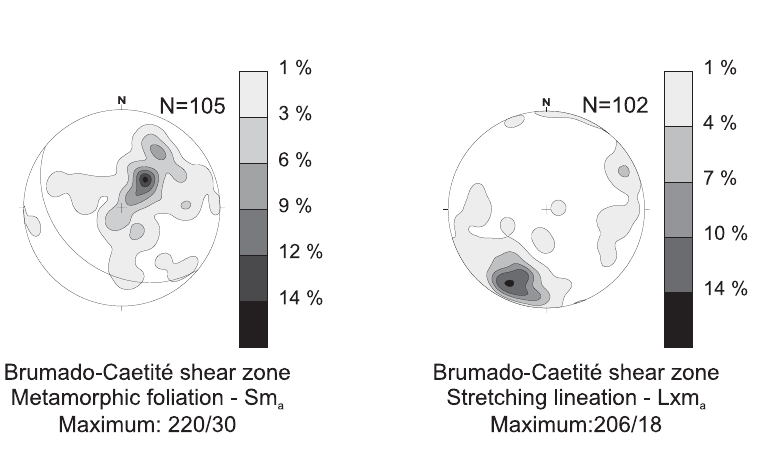
Fig. 8 – Equal-area, lower hemisphere stereonetplots of poles to foliations and lineations observed in the Brumado-Caetité shear